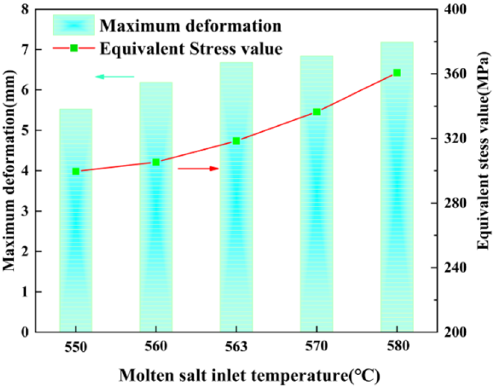
Figure 13. Maximum deformation and average equivalent stress values of heat exchangers with different molten salt inlet temperatures.